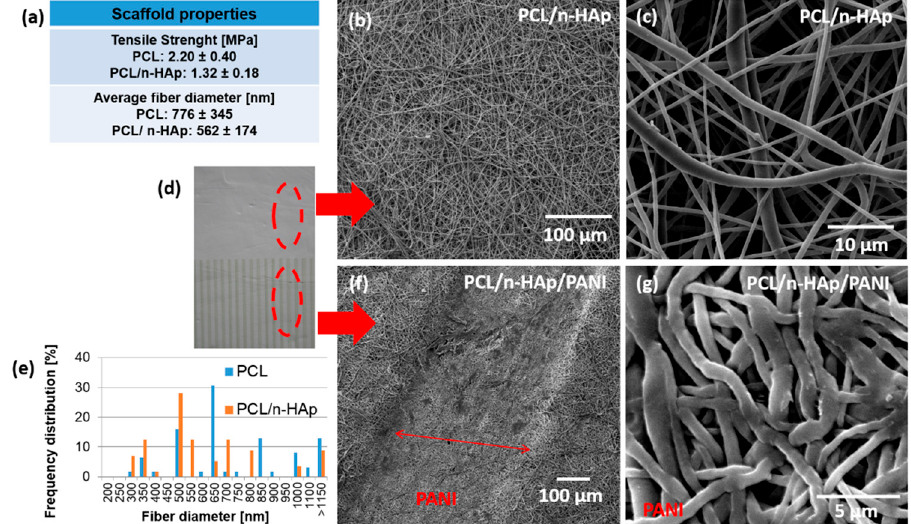
Figure 2. ( a ) Properties of the PCL/n-HAp scaffold. SEM images of the electrospun scaffolds: ( b , c ) PCL/n-HAp; ( d ) macroscopic image of PANI deposited on electrospun scaffold; ( e ) diameter of fiber distribution for PCL/n-HAp scaffold; ( f , g ) the layer of PANI deposited by inkjet printing on the surface of scaffold (PCL/n-HAp/PANI).